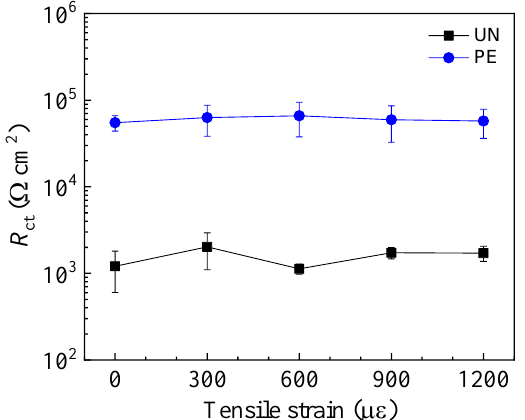
Figure 10. Comparison of the charge transfer resistance of the uncoated (UN) and enamel (PE)-coated steel rebar.